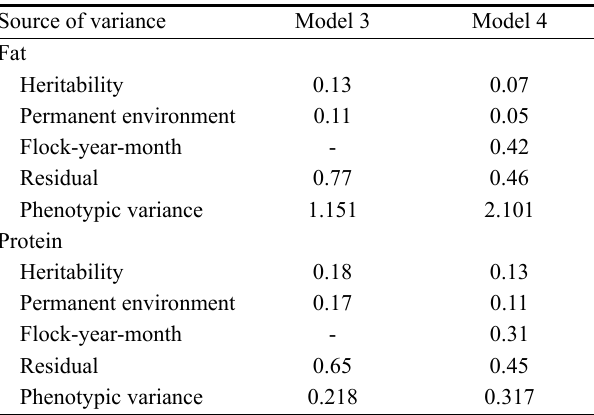
Table 3. Genetic correlations for fat and protein content between individual months of lactation (Model 2) Table 4. Variance ratios for random effects and total phenotypic variance for fat and protein content (univariate